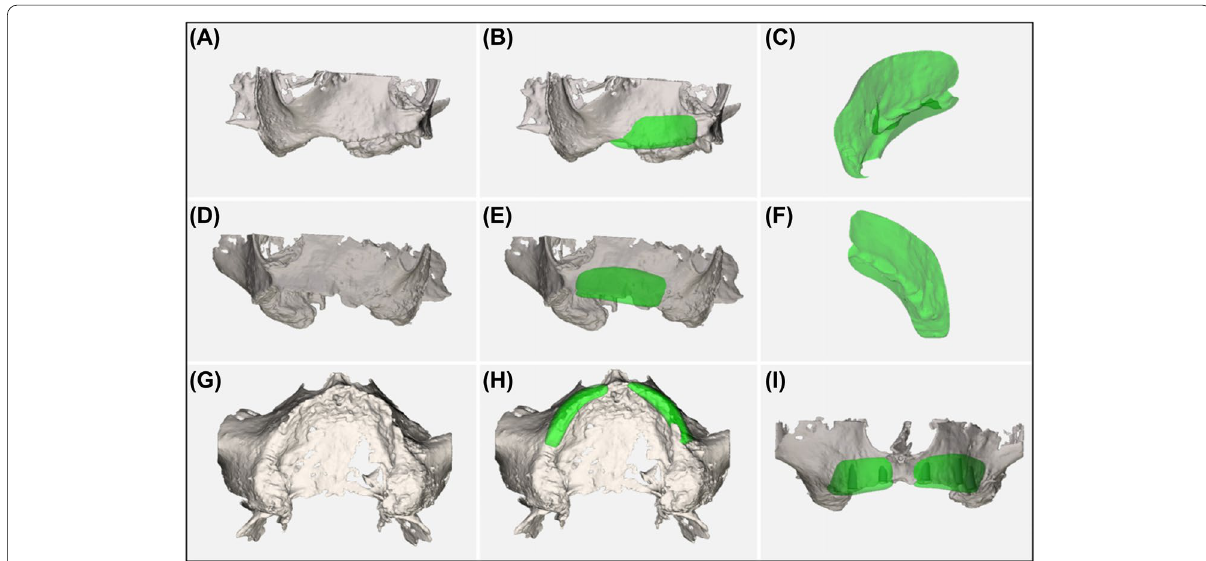
Fig. 3 Planning and designing process of the two CAD/CAM manufactured allogeneic bone blocks to fit exactly on an accurate defect model (J‑shaped design): A , D , and G Defect geometry; B , E , and H Allogeneic bone blocks on the defect model; C and F Allogeneic bone blocks; and I Allogeneic bone blocks, including optimized subsequent implant positions